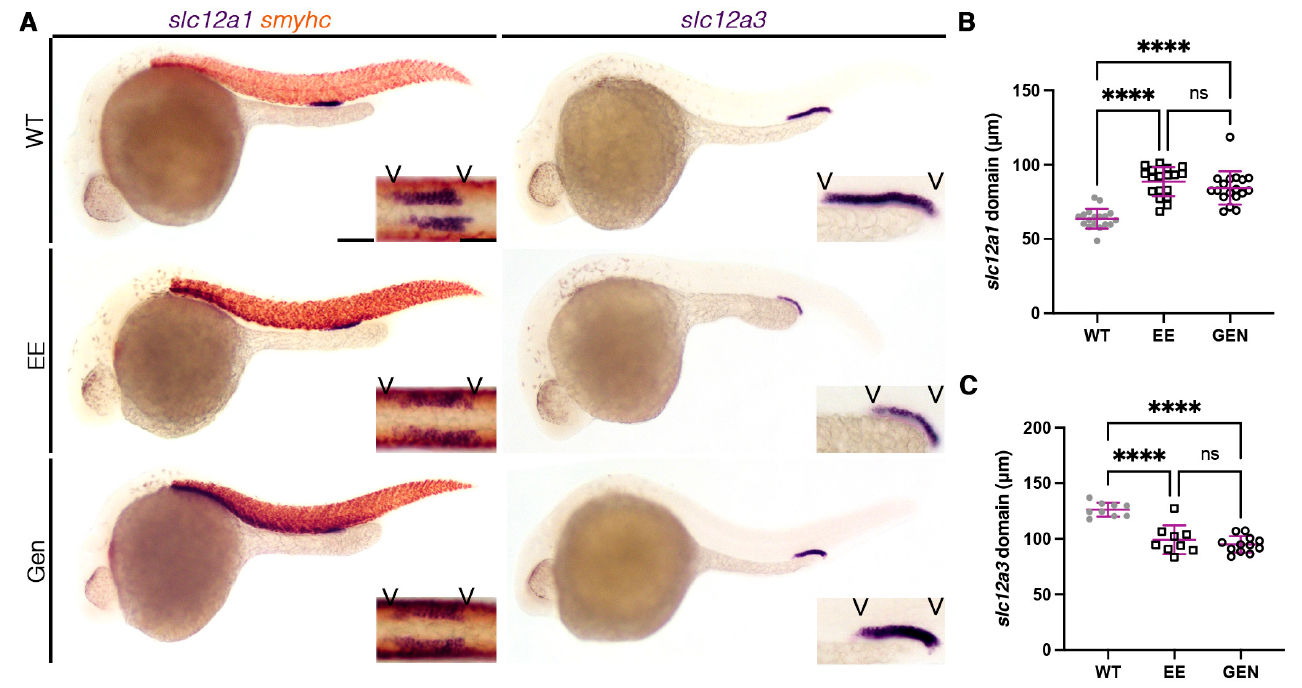
Figure 2. Xenoestrogens phenocopy E2 distal nephron segmentation phenotypes. ( A ) The 28 ss WT (top), 20 µ M ethinylestradiol (EE, middle), or 20 µ M genistein (GEN, bottom) treated animals stained via WISH for the DE marker ( slc12a1 ) with the somite marker ( smyhc ) (left), or the DL marker ( slc12a3 ) (right). Scale bar = 100 µ m for lower magnification, scale bar = 50 µ m for higher magnification. ( B , C ) DE and DL domain lengths at 28 ss in micrometers. Data presented on graphs are represented as mean ± SD. **** p < 0.0001 (ANOVA).